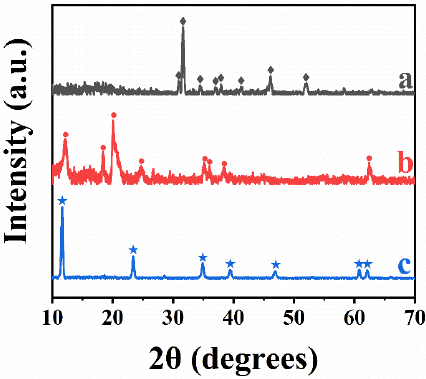
Figure 5. XRD patterns of as-deposited composite coatings: ( a ) PEMA-huntite, ( b ) PEMA-halloysite, and ( c ) PEMA-hydrotalcite ( ♦ —JCPDS file 14-0409, ● —JCPDS file 09-0453, ★ —JCPDS file 50-1684).